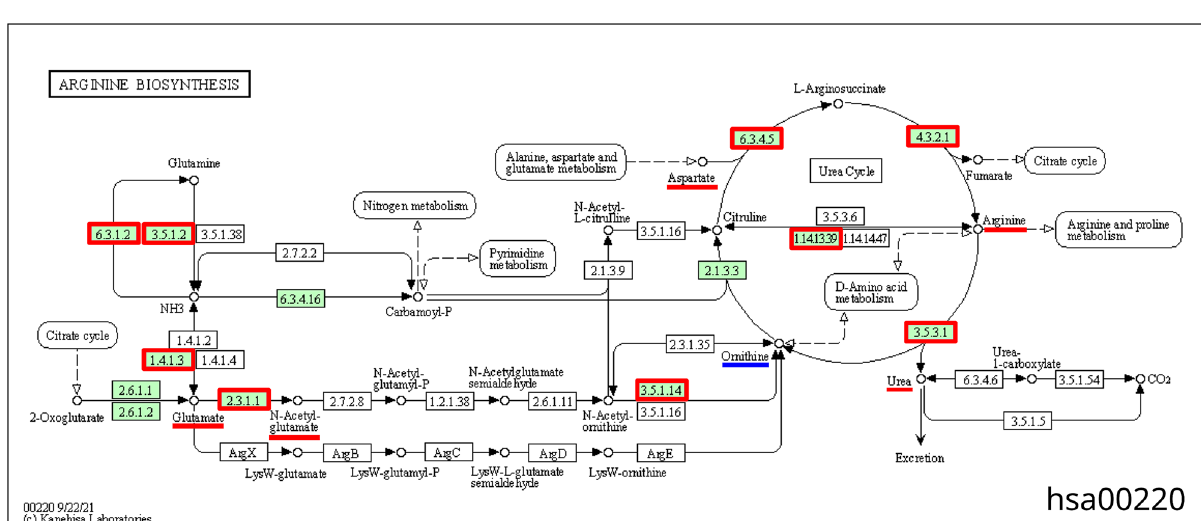
Figure 5. The scheme of arginine biosynthesis extracted from KEGG database 28 (Id hsa00220). Enzymes that can be the potential targets of viral proteins are shown by red boxes, the metabolites increased in the plasma of COVID-19 patients are underscored by red line, while those decreased are underscored by blue